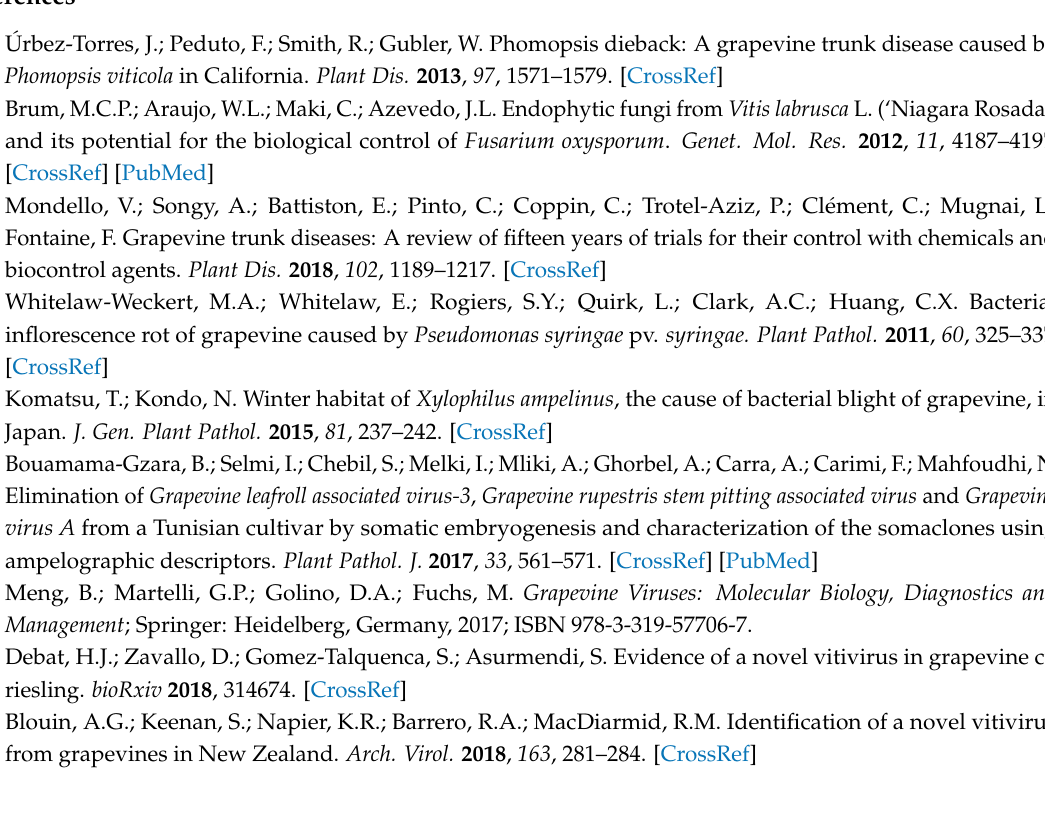
Table S1: The main ELISA test systems for the control of grapevine virus pathogens that are commercially available, Table S2: The main commercial kits based on nucleic acid amplification for grapevine viruses